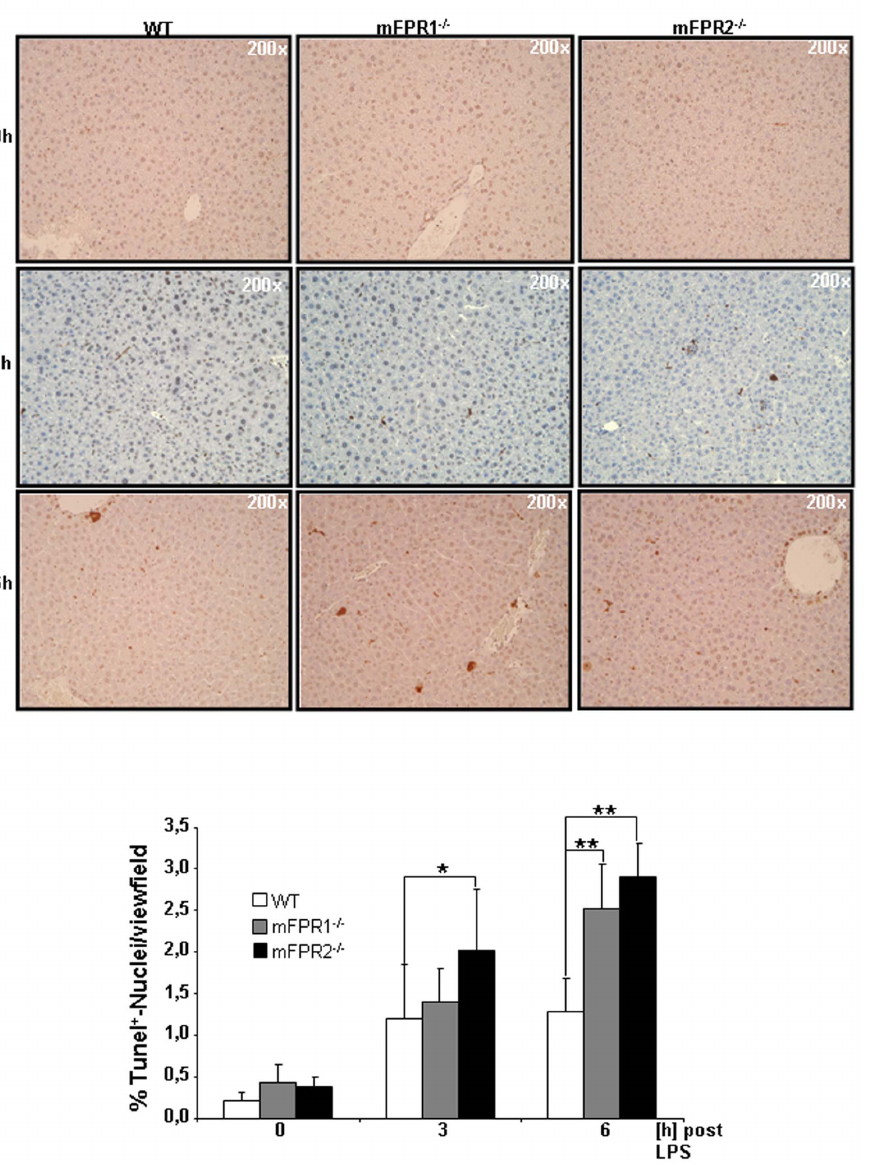
Figure 5. For determination of the liver injury FFPE-section were stained for DNA-strand breaks using a TUNEL-assay. Tunel + -cells were counted. Counterstaining was perfomed using Haematoxylin (A). Pictures were taken in 200 fold magnification. Results displaying an increase of TUNEL + -cells in regard to mFPR1 and mFPR2-deficiency are shown as a Graph (B). (*=p , 0.05; **=p , 0.01.)